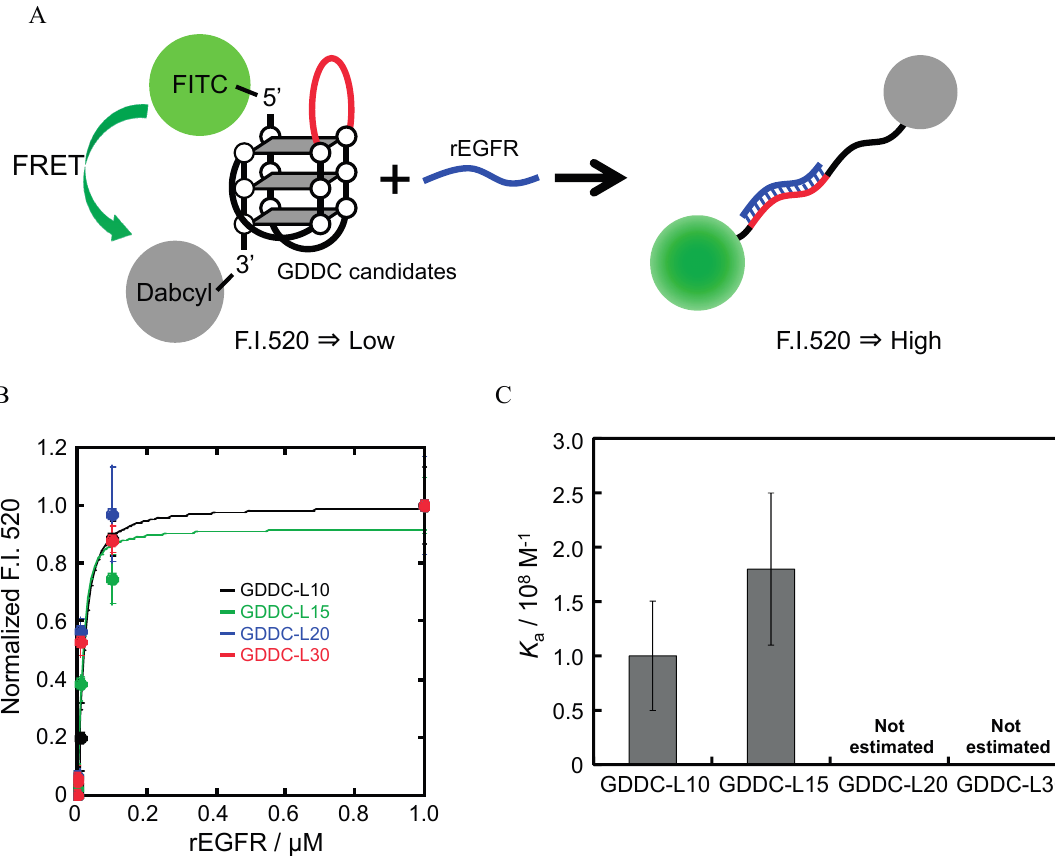
Figure 8. ( A ) Strategy to study the unfolding of GDDCs by Regfr; ( B ) Normalized fluorescence intensity (F.I.) of each GDDC (20 nM) at 520 nm with 0–10 µM rEGFR. (B) K a values of rEGFR for HteloDNA and each GDDC. All measurements were carried out in a buffer containing 50 mM MES-LiOH (pH 7.0), 100 mM KCl, and 10 mM MgCl 2 at 25 °C. K a values of GDDC-L20 and GDDC-L30 were too high to evaluate